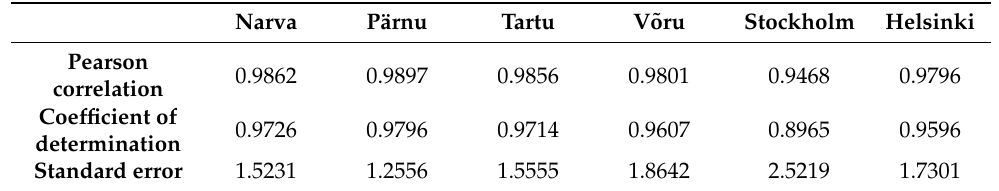
Table 3. Correlation of the average daily surface air temperatures in the different cities with the average daily air temperature in Tallinn—correlation statistics.